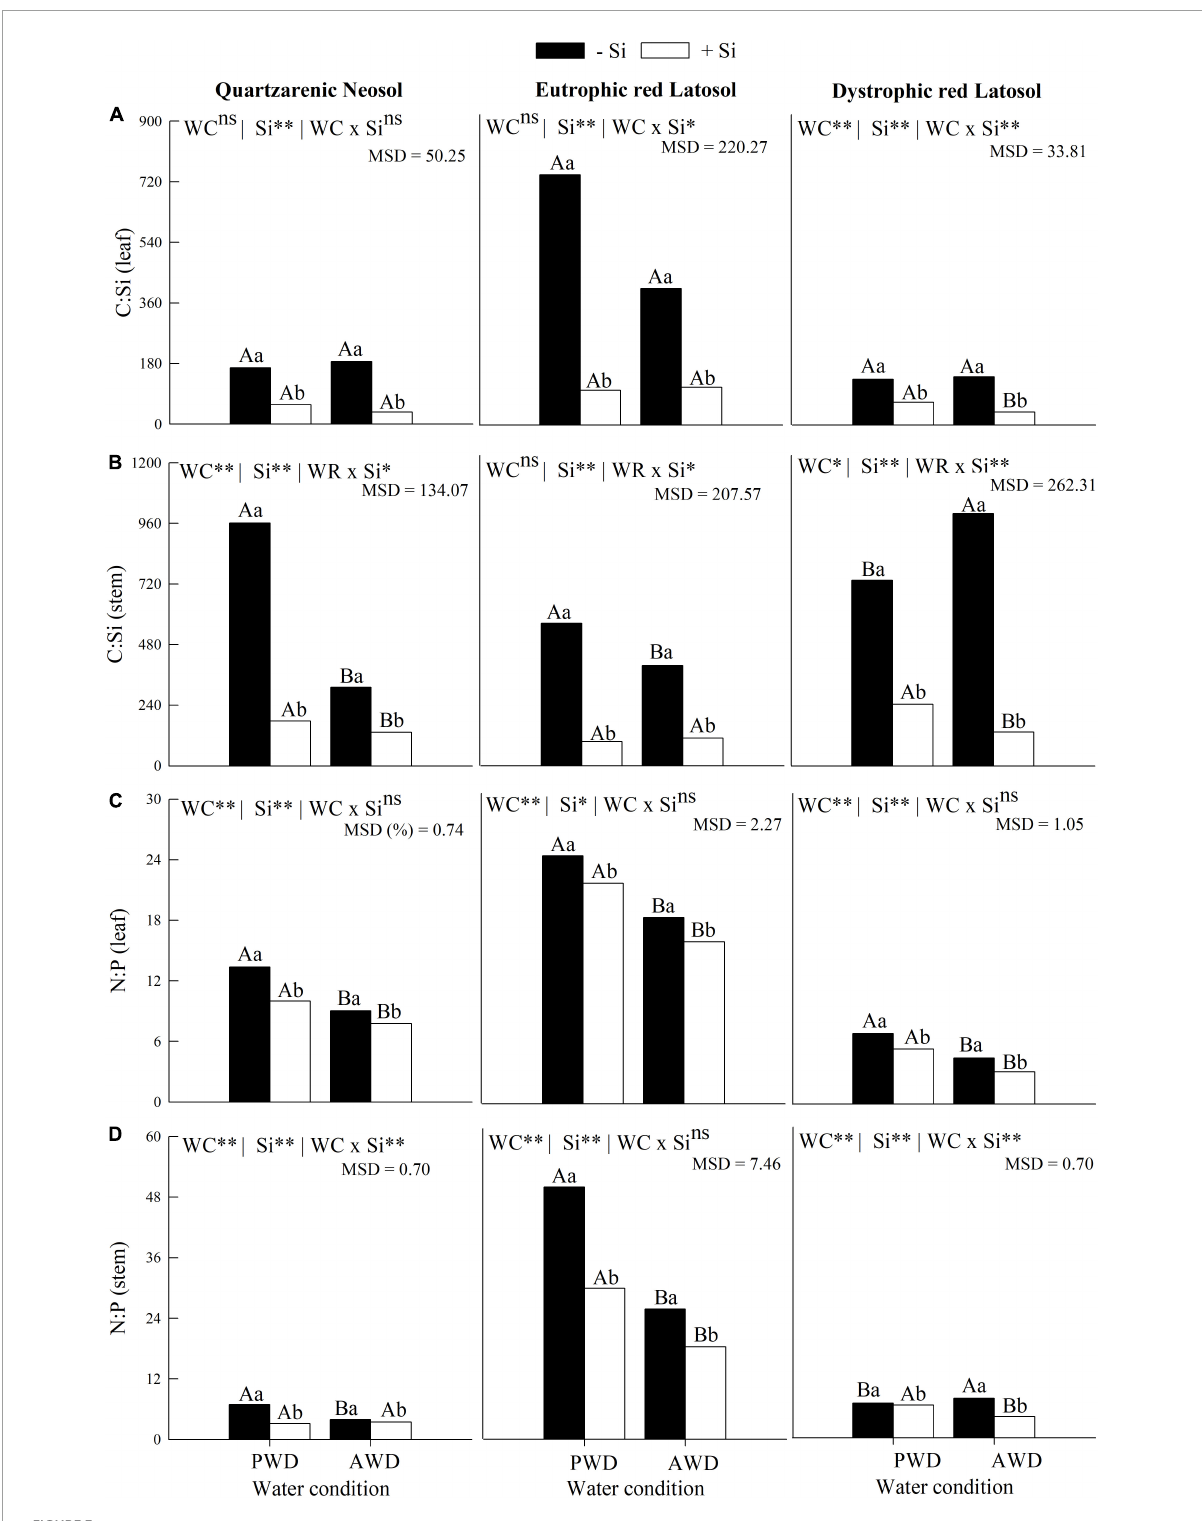
FIGURE3 Stoichiometric ratios of C:Si (A,B) and N:P (C,D) in leaves and stems of sugarcane cultivated with absence (0.0 mM) and presence of fertigated Si (1.8 mM) and two water conditions (without—AWD and with water deficit—PWD) in three tropical soils (Quartzarenic Neosol; Eutroferric Red Latosol; and Dystrophic Red Latosol). WC, water condition; MSD, minimum significant difference; ** and *: significant at 1 and 5% probability, respectively; NS, not significant at 5% probability. Different uppercase letters indicate differences in water conditions and different lowercase letters indicate differences in Si fertigation by Tukey’s test ( p <